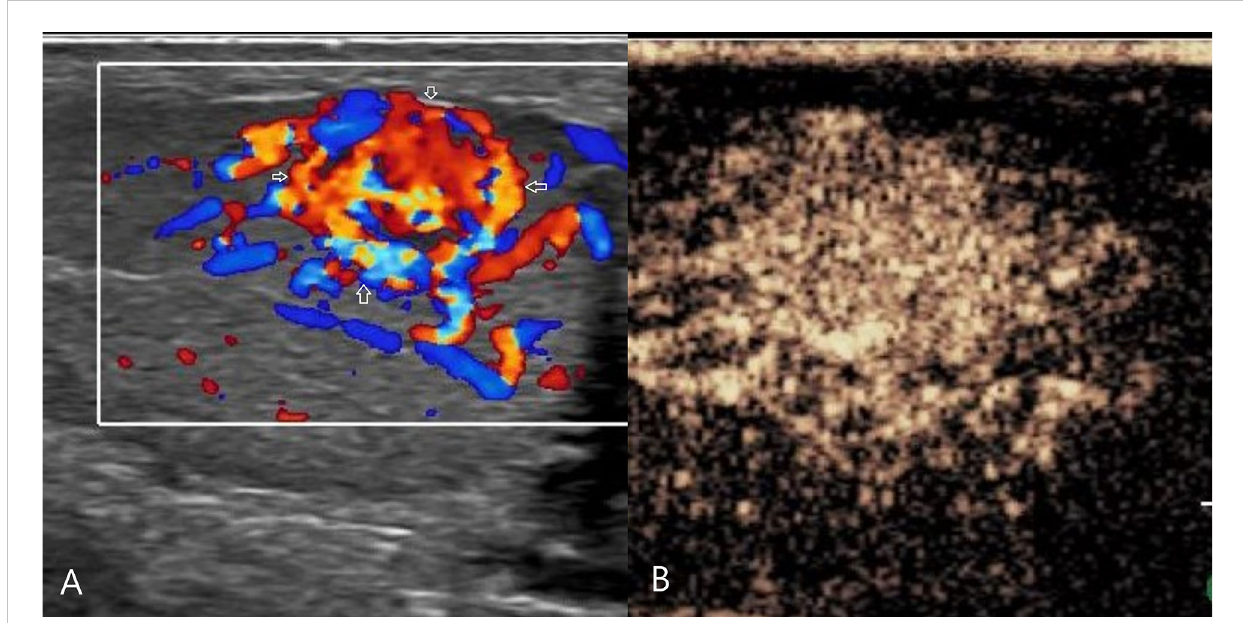
FIGURE 4 Leydig cell tumor. (A) CDFI: hypoechoic mass in the left testis, abundant blood fl ow, with annular blood fl ow around(arrow). (B) CEUS: uniform and high enhancement, and no obvious necrotic area was found. CDFI, Color Doppler Flow Imaging; CEUS, contrast-enhanced